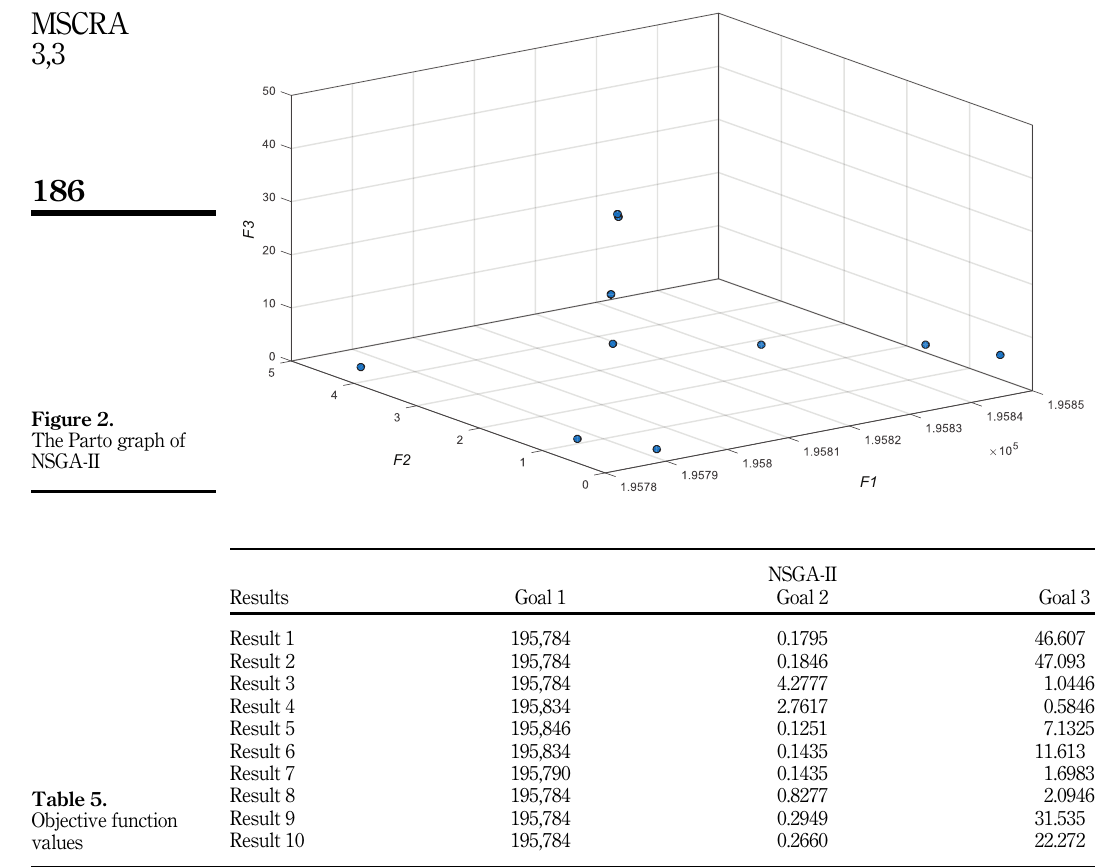
Table 5. Objective function values